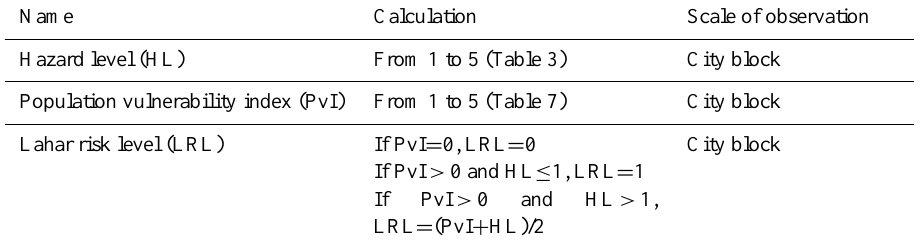
Table 8. Evaluating the risk level based on hazard level and overall population vulnerability. This table provides an overall measure of flood and lahar risk for the city of Arequipa. The lahar risk level (LRL) is the combination (using an equal weight) of the hazard level calculated in Table 3 and the population vulnerability index calculated in Table 7. Starting from its elaboration, LRL only concerns the banks of the rivers and the quebradas that cross Arequipa. Figure 13 shows the resulting map for the whole city and Fig. 14 for Quebrada San